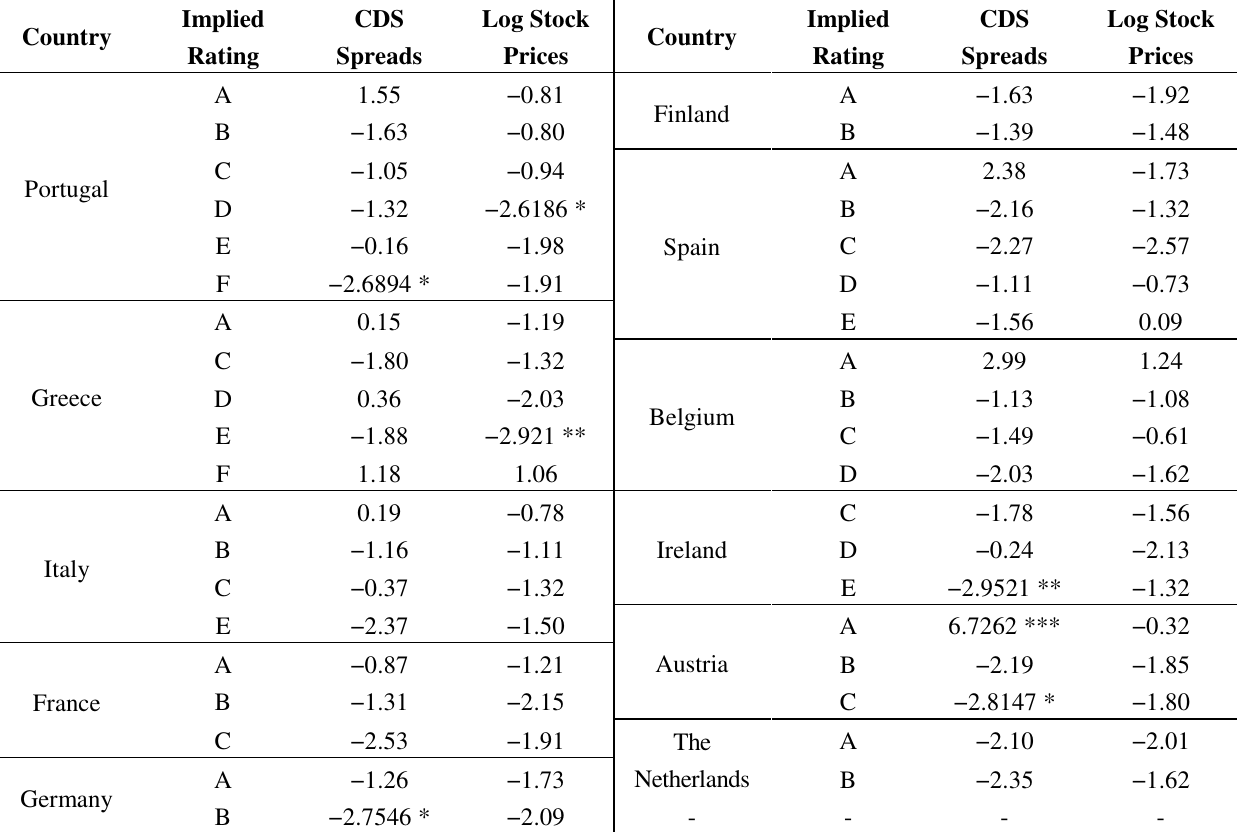
Table 3. Augmented Dickey–Fuller unit root